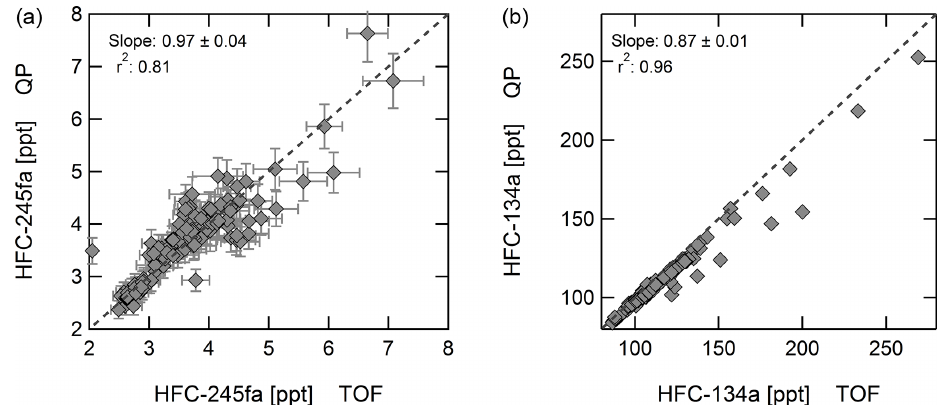
Figure 4. Correlation at Taunus Observatory of HFC-134a and HFC-245 for the mass spectrometers employed, a quadrupole (QP), and a time-of-flight (TOF) mass spectrometer. The solid line represents an orthogonal fit to the data points; the dotted line indicates the 1 : 1 line. For HFC-134a a non-linearity is observed for the TOF MS but not for HFC-245fa. Error bars of HFC-134a mixing ratios are smaller than symbol